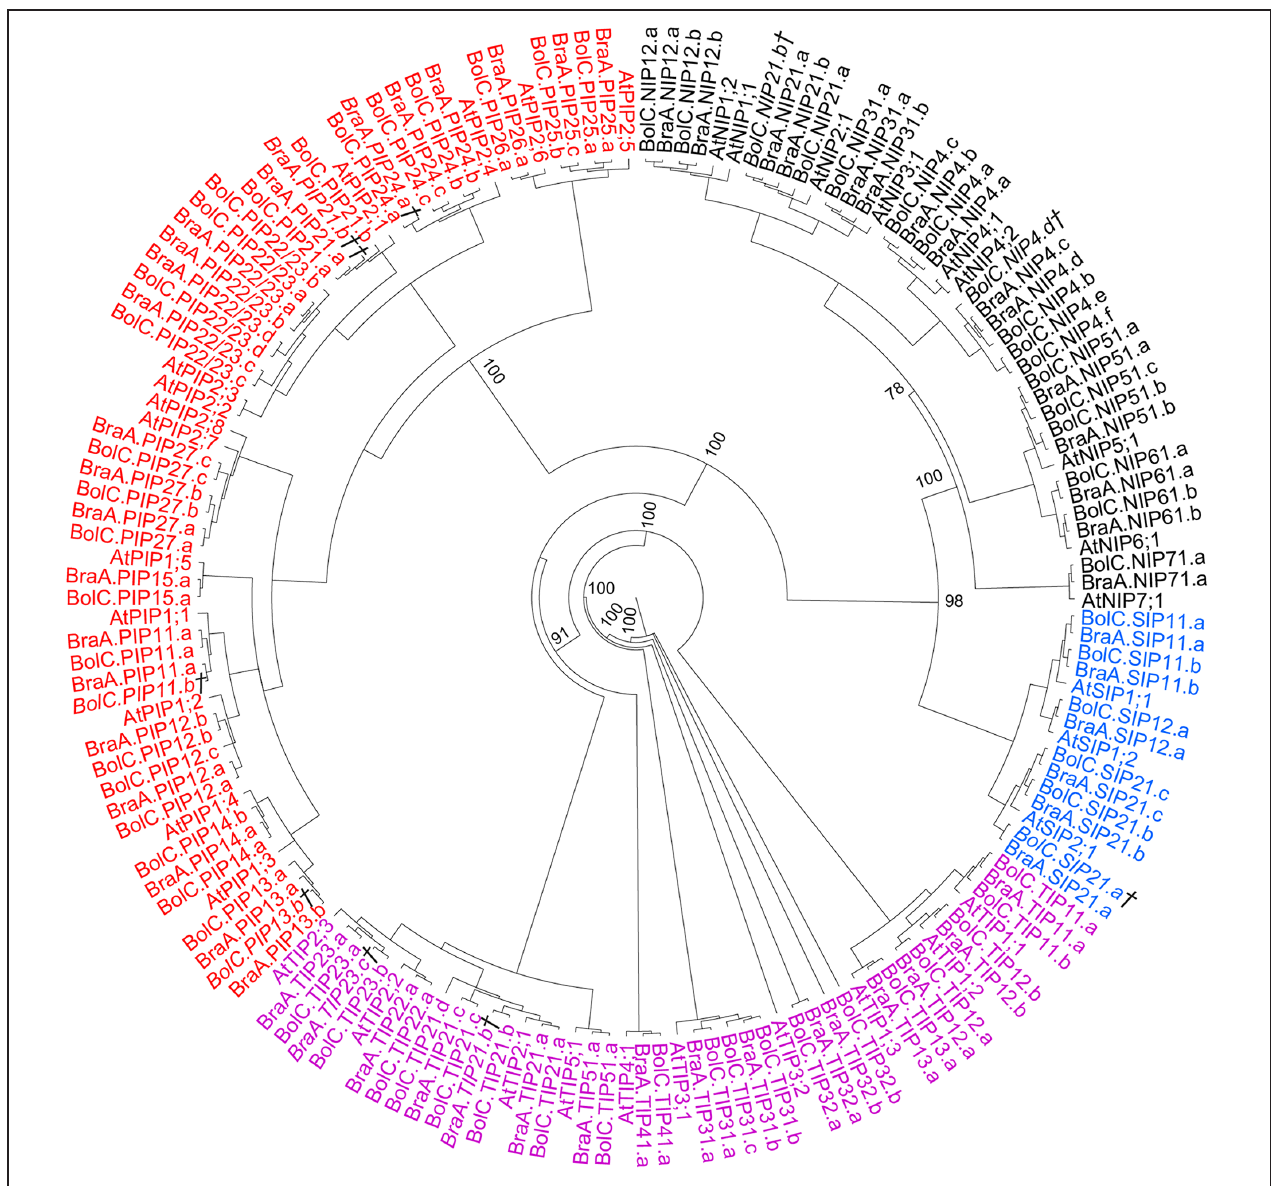
FIGURE 2 | Phylogeny of AQPs. Phylogenetic tree derived from AQP cDNA sequences of B. oleracea , B. rapa, and A. thaliana using Bayesian phylogenetic inference. Numbers beside the nodes indicate the posterior probability values > 75% for the inner nodes (more details in the separate trees for each AQP subfamily). Genes displayed in black belong to the NIP-, in red to the PIP-, in